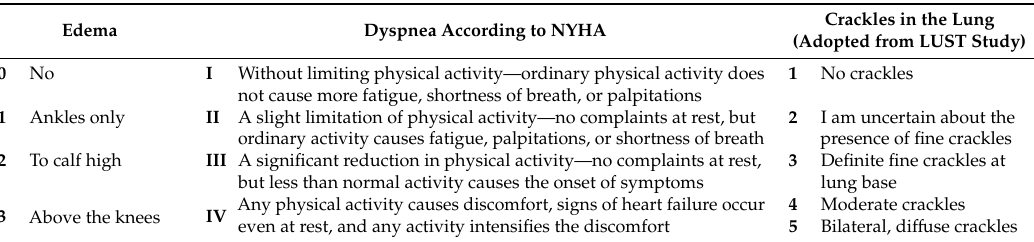
Table 2. Criteria for clinical evaluation of